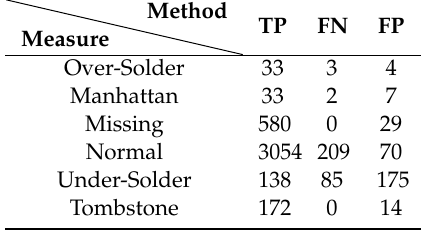
Table A3. Classification results of late-merge dual-stream CNN.